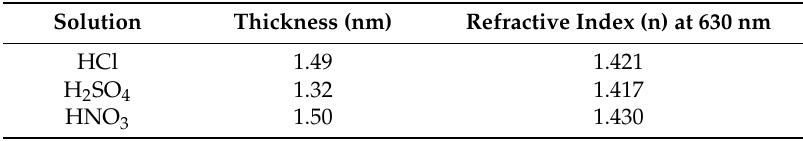
Table 1. SiO x layer thickness and refractive index (n) at an immersion time of 15 min. The data are averaged with ten samples. Figure 2. Transmission electron microscopy (TEM) images of the wet chemical oxide (SiO x-HNO3 ) layer in an SiN x /SiO x /Si structure.